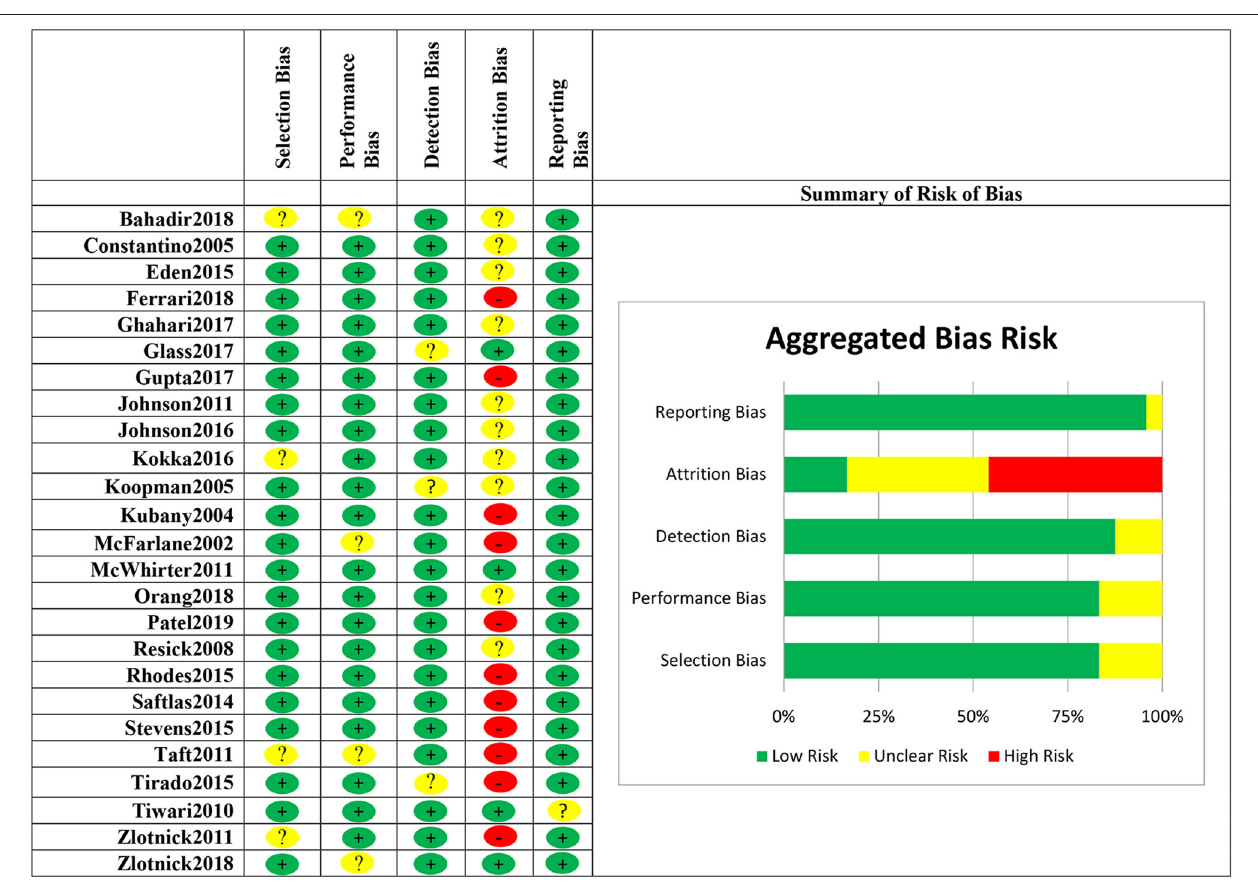
groups had lower levels of depressive symptoms at the post- test for the intervention group (SMD = − 0.26, CI − 0.56